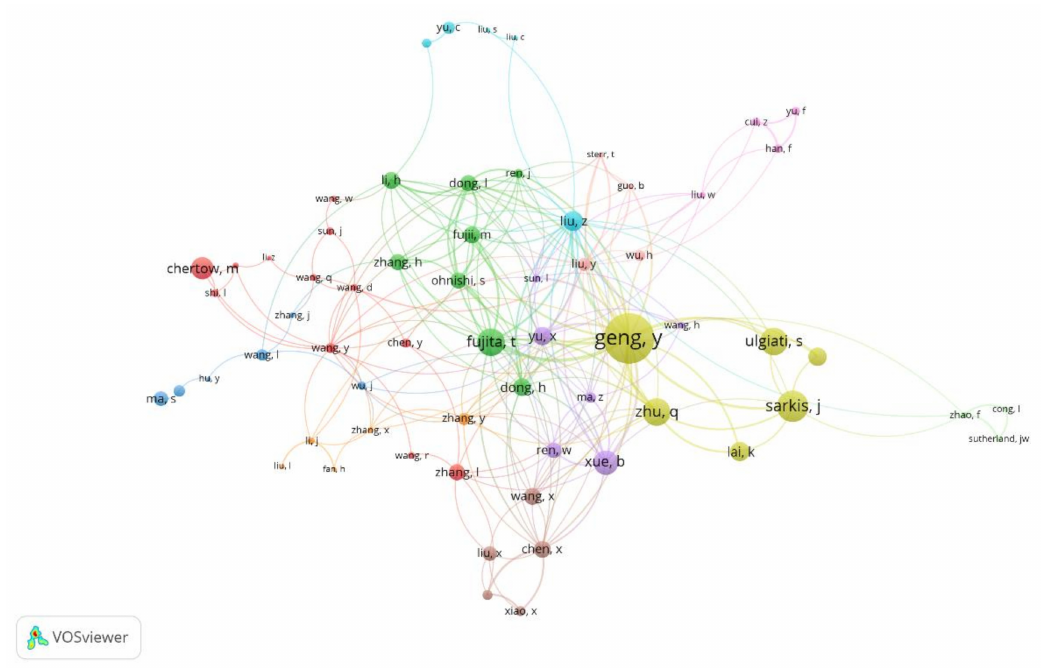
Figure 6. Cocitation map based on bibliographic